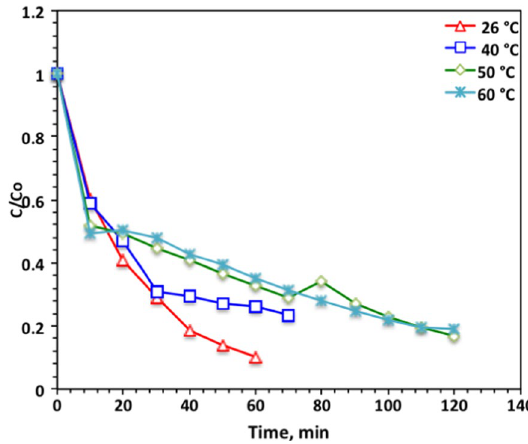
Fig. 8 Thermal effect on BB9 oxidation via CS-M-based Fenton sys- tem